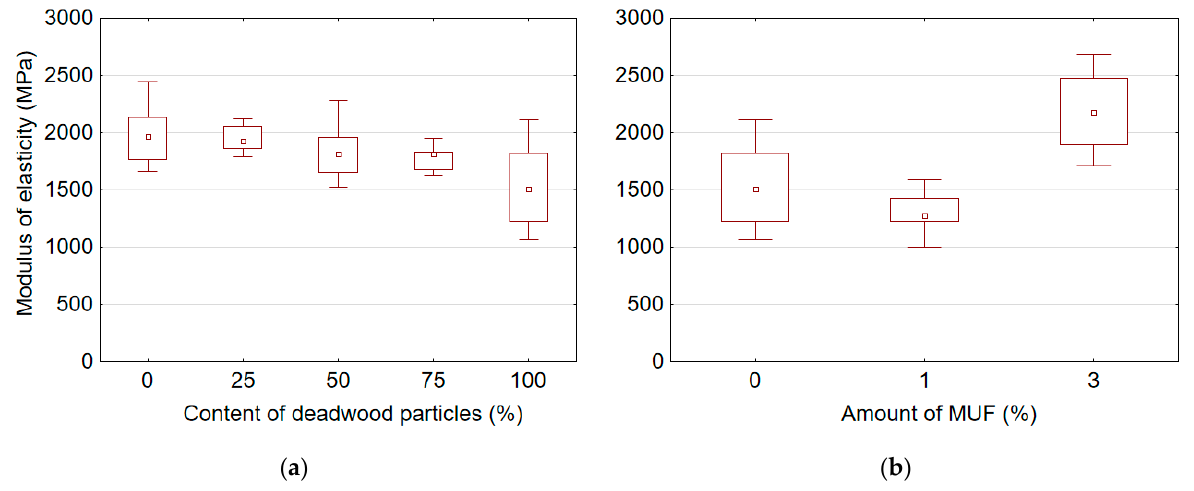
Figure 7. Modulus of elasticity of boards samples depending on content of deadwood particles ( a ) and amount of MUF resin in adhesive ( b ).